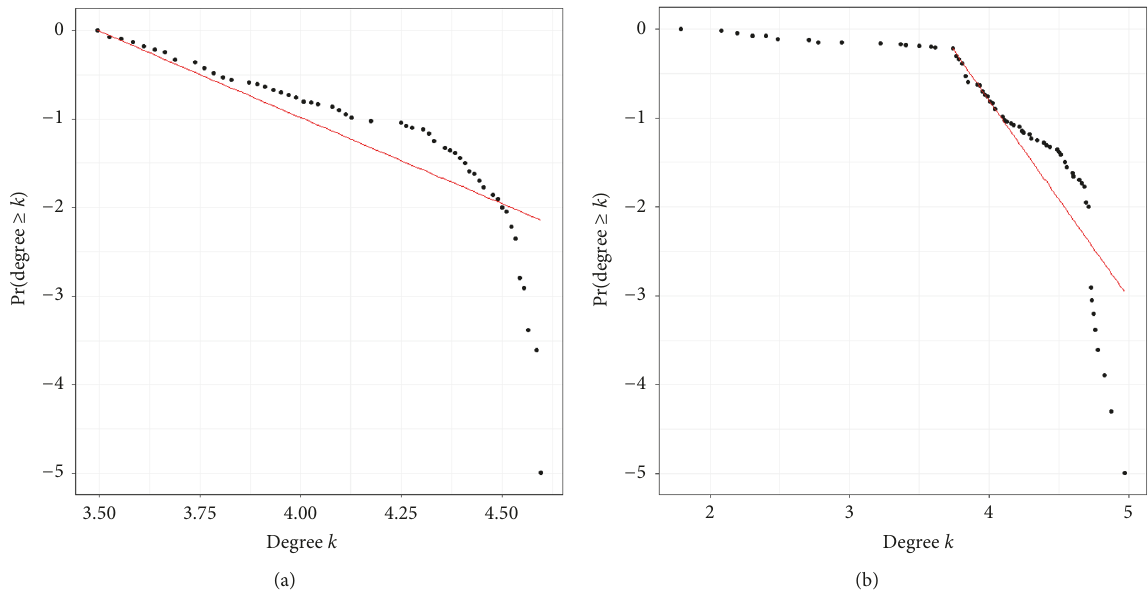
Figure 7: Power-law fitting of (a) the scale-free network and (b) the PJM voting